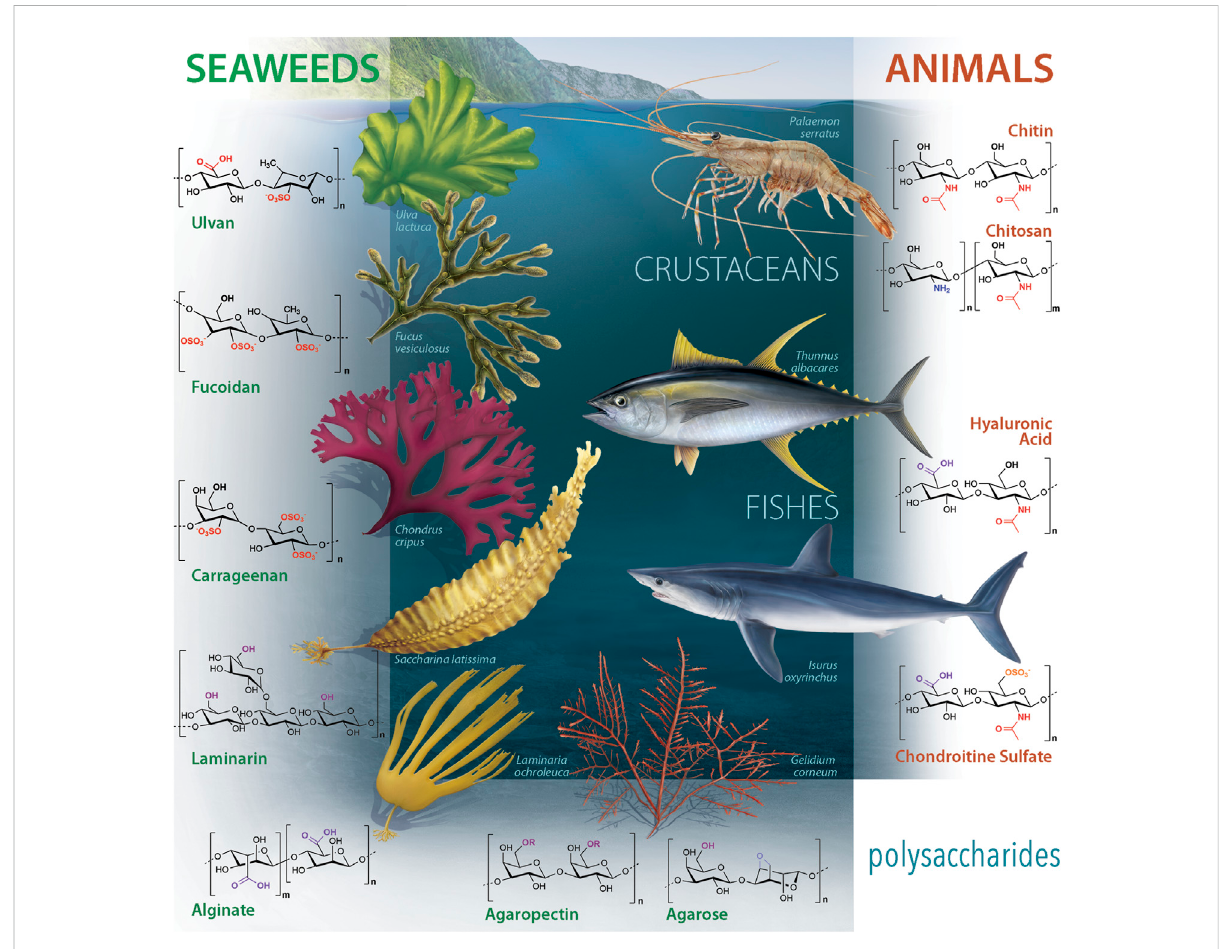
FIGURE 1 Marine-origin polysaccharide portfolio: chemical structures and representative marine